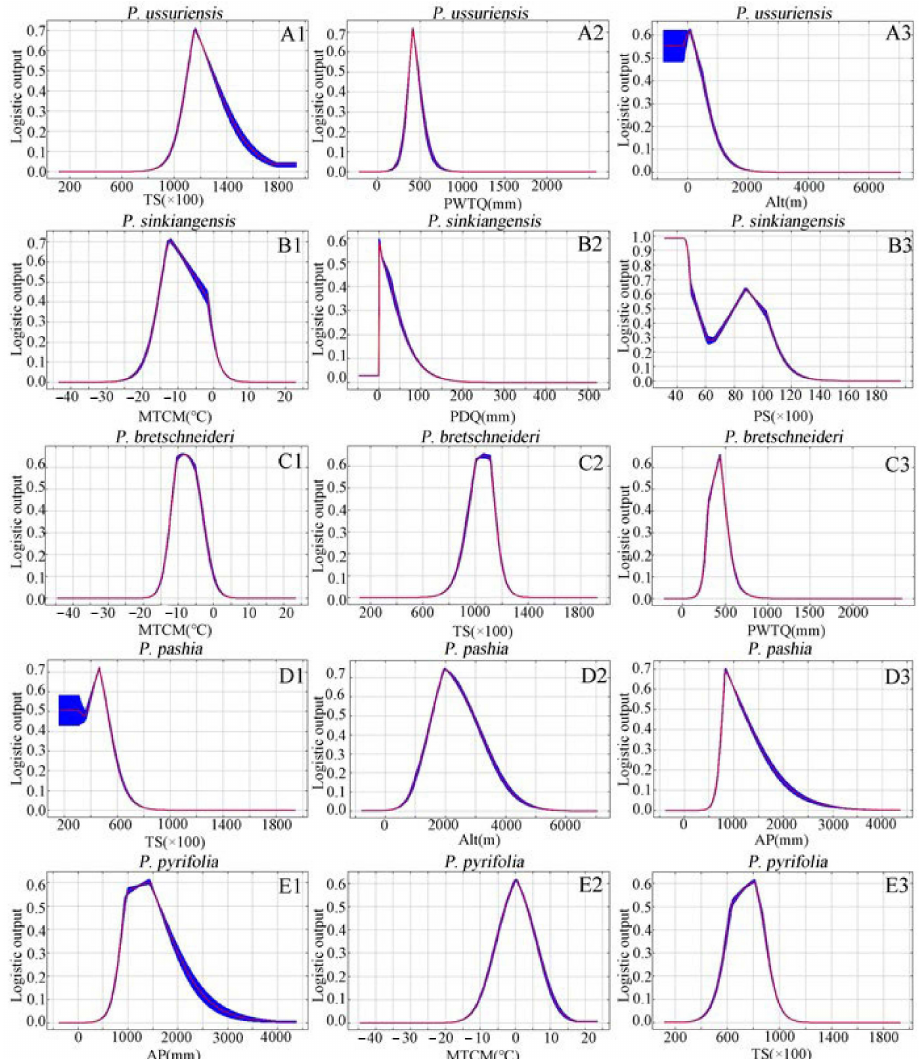
Figure 2. Response curves of the existence probability (habitat suitability) of five species of pear to major environmental variables with simulated distribution under current climatic conditions. ( A1 – A3 ) P. ussuriensis , ( B1 – B3 ) P. sinkiangensis , ( C1 – C3 ) P. bretschneideri , ( D1 – D3 ) P. pashia , ( E1 – E3 ) P. pyrifolia . The Maxent logistic output (also known as habitat suitability) was represented by the vertical axis, while the environmental variables were represented by the horizontal axis. With a logical output value greater than 0.5, the probability of species presence under the given condition was considered to be suitable for the species. Note: the red curves show the average over 10 replicate runs; blue bands show the standard deviation (SD) calculated over 10